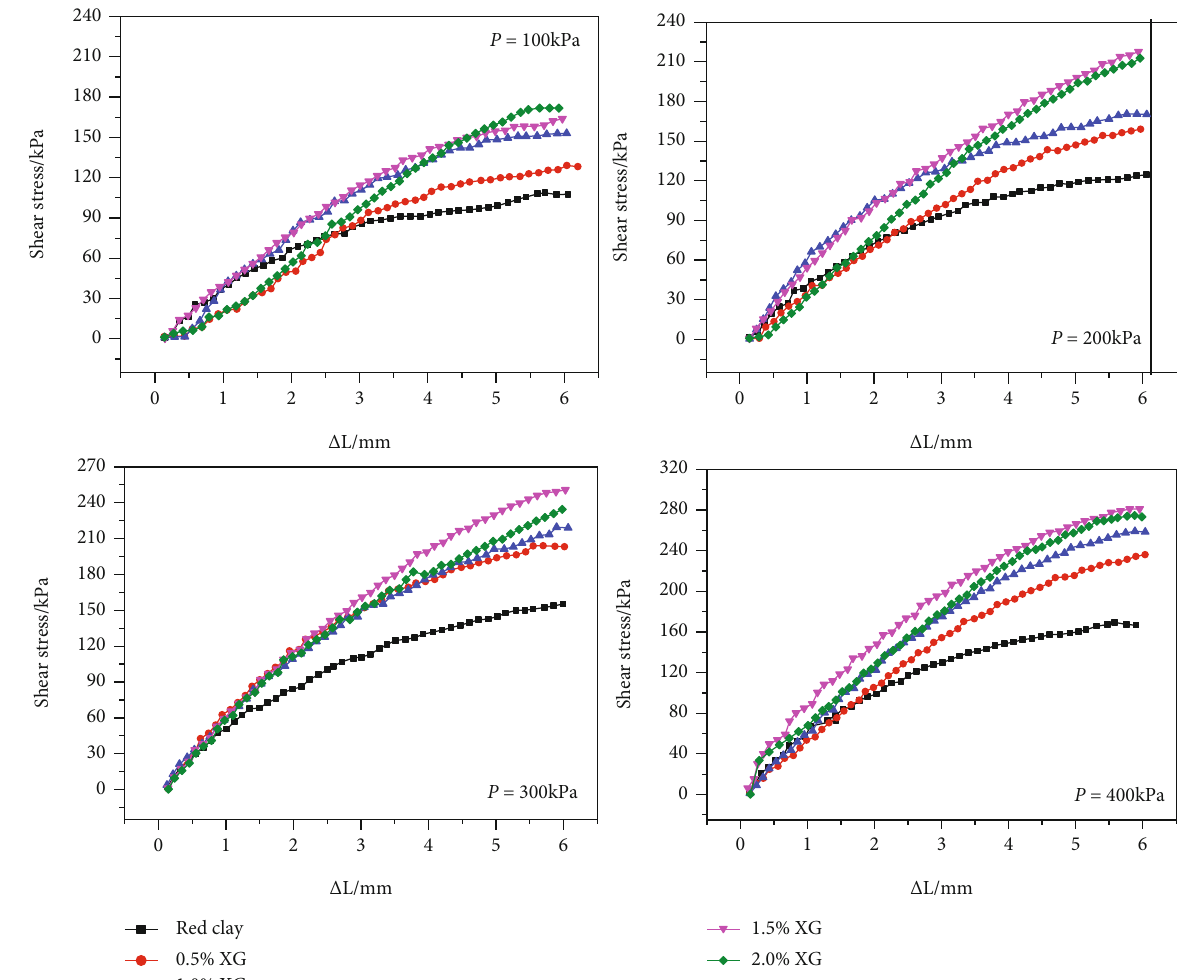
Figure 9: Shear stress and shear displacement of soil after curing for 7